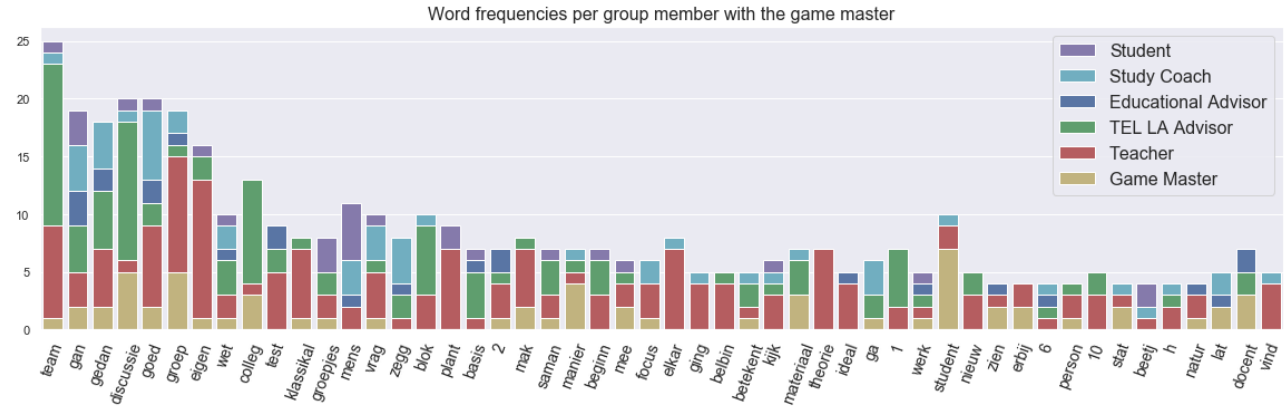
Figure 6. Top 50 word utterance frequency in the blue phase with roles.